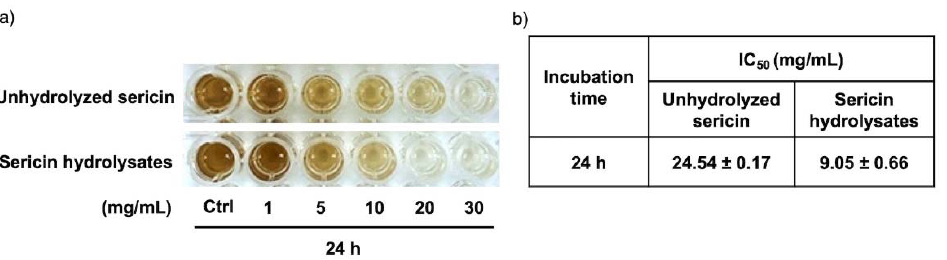
Figure 3. The more potency of Alcalase ® -hydrolyzed sericin on suppression of melanin production when compared with unhydrolyzed sericin was evidenced by ( a ) the lower cellular melanin content and ( b ) half-maximum inhibitory concentration (IC 50 ) in human melanin-producing cells after 24 h of treatments.